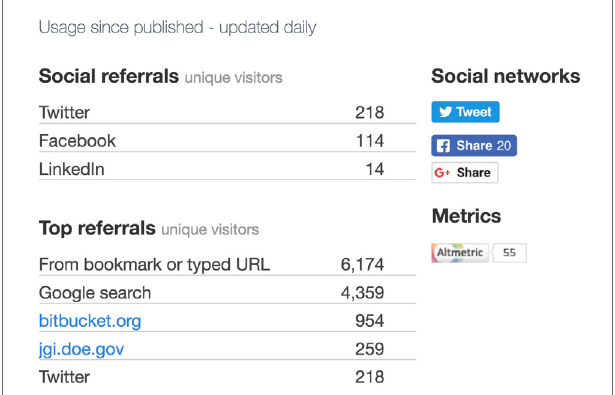
FigUre 1 | Referrals of a PeerJ paper.